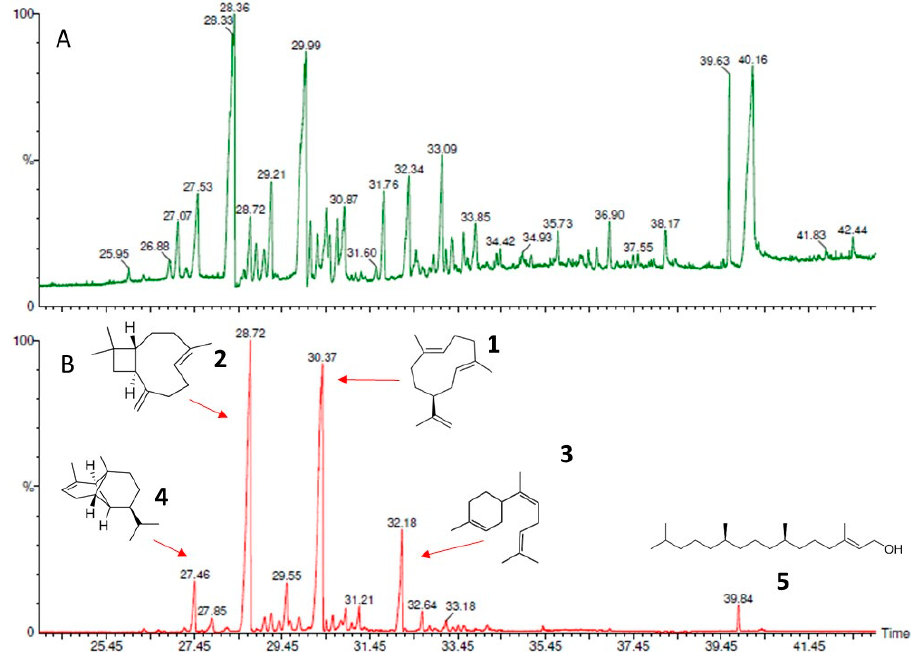
Figure 8. Chromatograms of the Cedrela odorata essential oil: ( A ) oil extracted with dichloromethane from the nanoemulsion of the C. odorata essential oil at 2.5%; and ( B ) oil extracted by hydrodistillation from the C. odorata dehydrated leaves. Major components: 1 = germacrene D; 2 = caryophyllene; 3 = cis- α -bisabolene; and 4 = copaene, 5 = phytol.